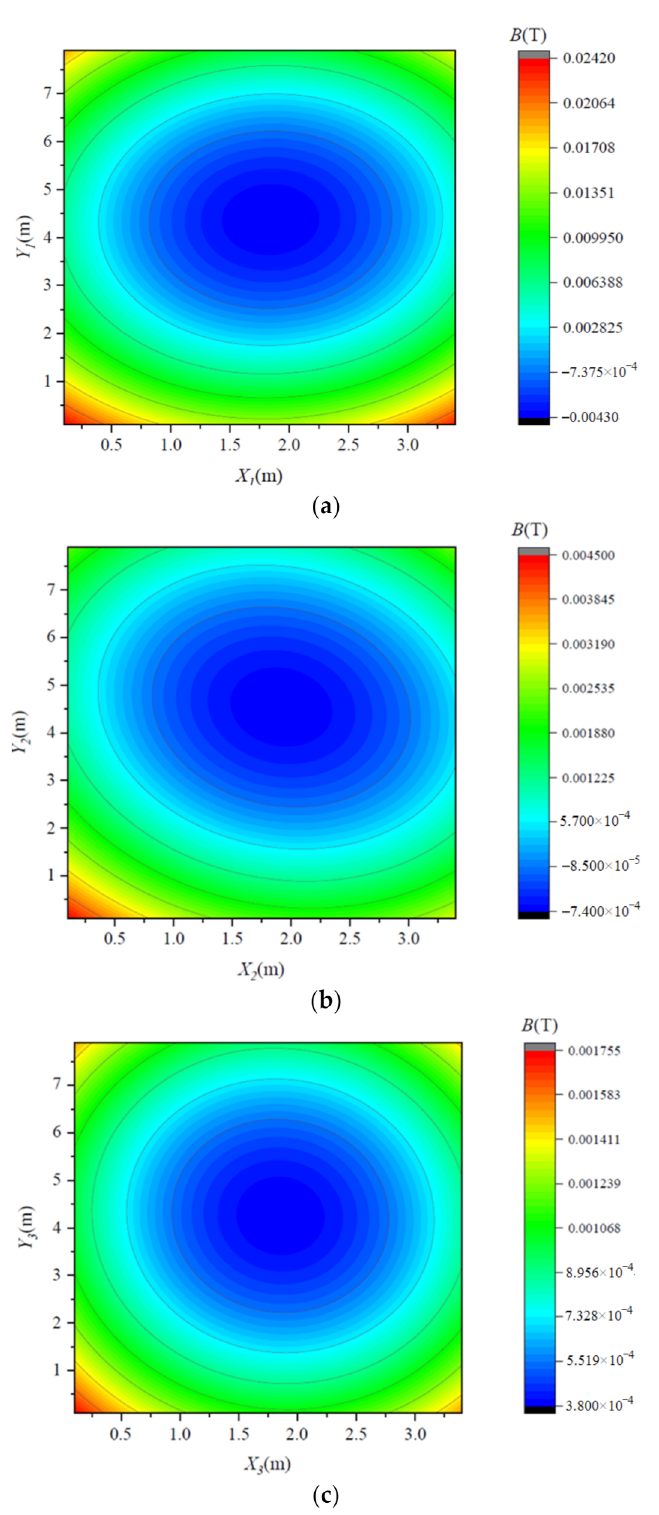
Figure 15. Magnetic field distributions under − 1/200 µ s and 50 kA. ( a ) Mesh 1, ( b ) mesh 2, ( c ) mesh